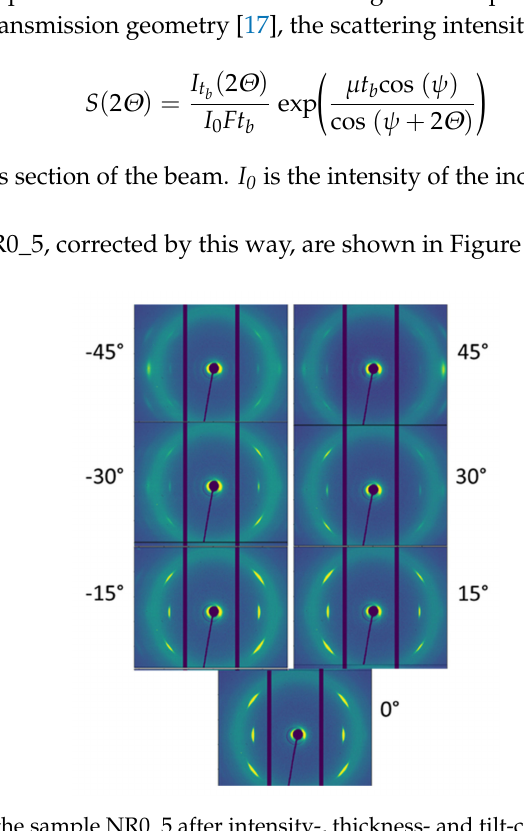
Figure 3. Patterns of the sample NR0_5 after intensity-, thickness- and tilt-correction in dependence of the angle of rotation of the sample around the tensile axis, which is vertical. Rotation angle ± 45 ◦ , ± 30 ◦ , ± 15 ◦ , 0 ◦ (from top to bottom, in